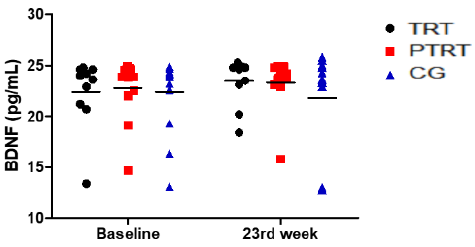
Figure 3. E ff ects of TRT and PTRT on BDNF levels. TRT = Traditional resistance training; Figure 3. Effects of TRT and PTRT on BDNF levels. TRT = Traditional resistance training; PTRT = PTRT = Combined power training and resistance training; CG = Control Combined power training and resistance training; CG = Control group.